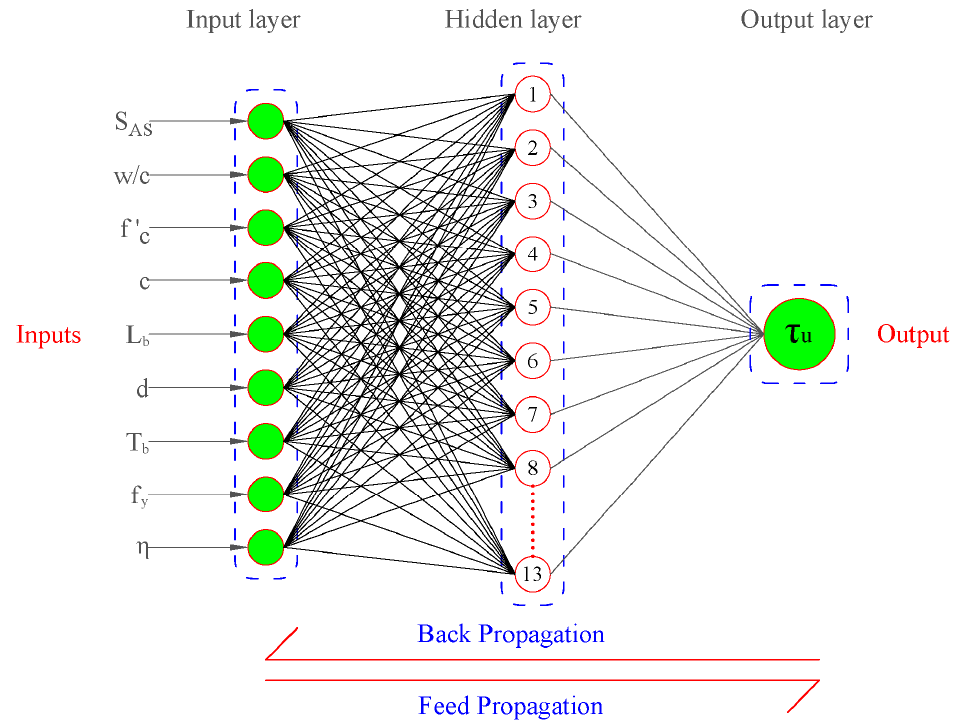
Figure 4. Architectural diagram of ANN.